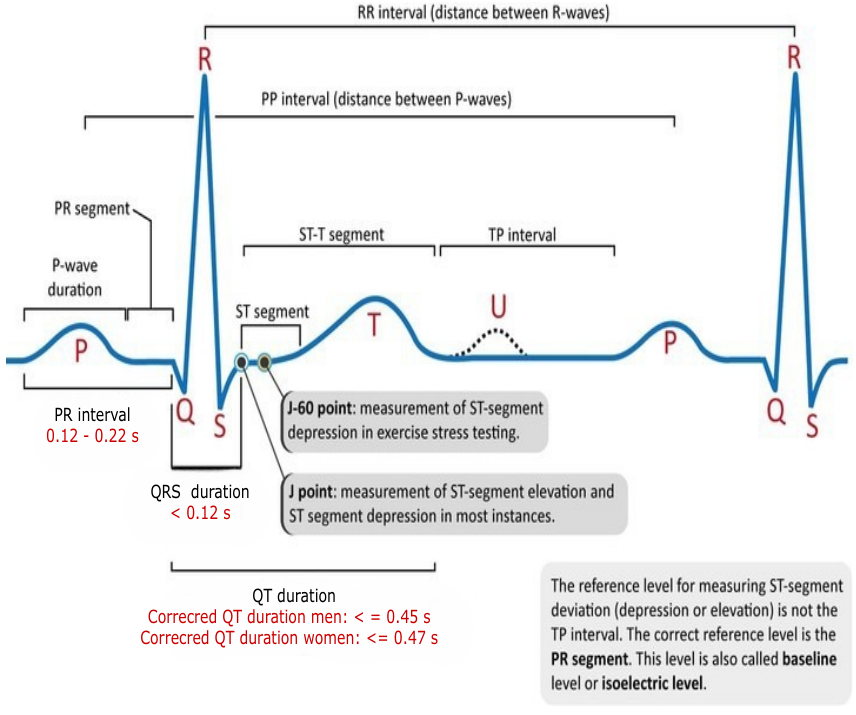
Figure 1. Representation of complete electrical activity of the